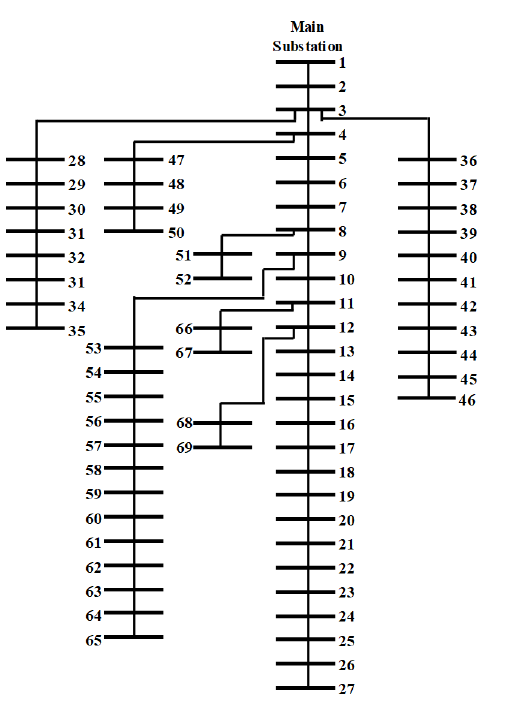
Figure 8. IEEE 69-bus